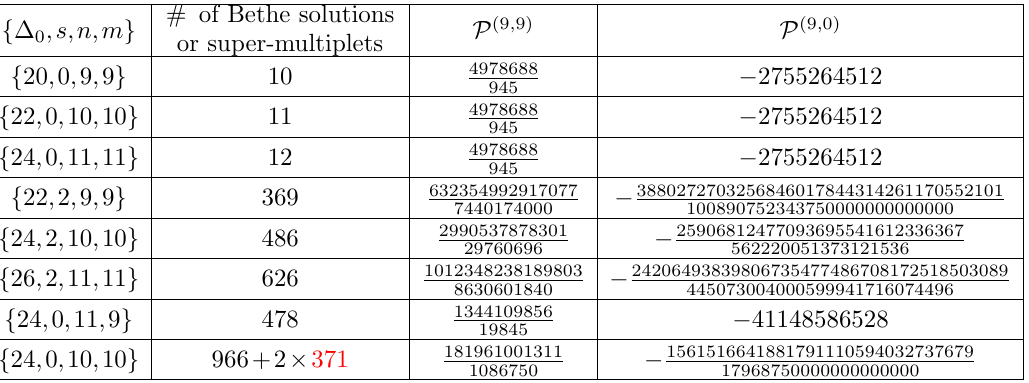
Table 10 . The number of Bethe solutions or number of long super-multiplets on each of the 8 super- classes involved in our consistency check. The highlighted 371 is number of so (6) Bethe solutions with non-identical wings, which have vanishing structure constants according to equation